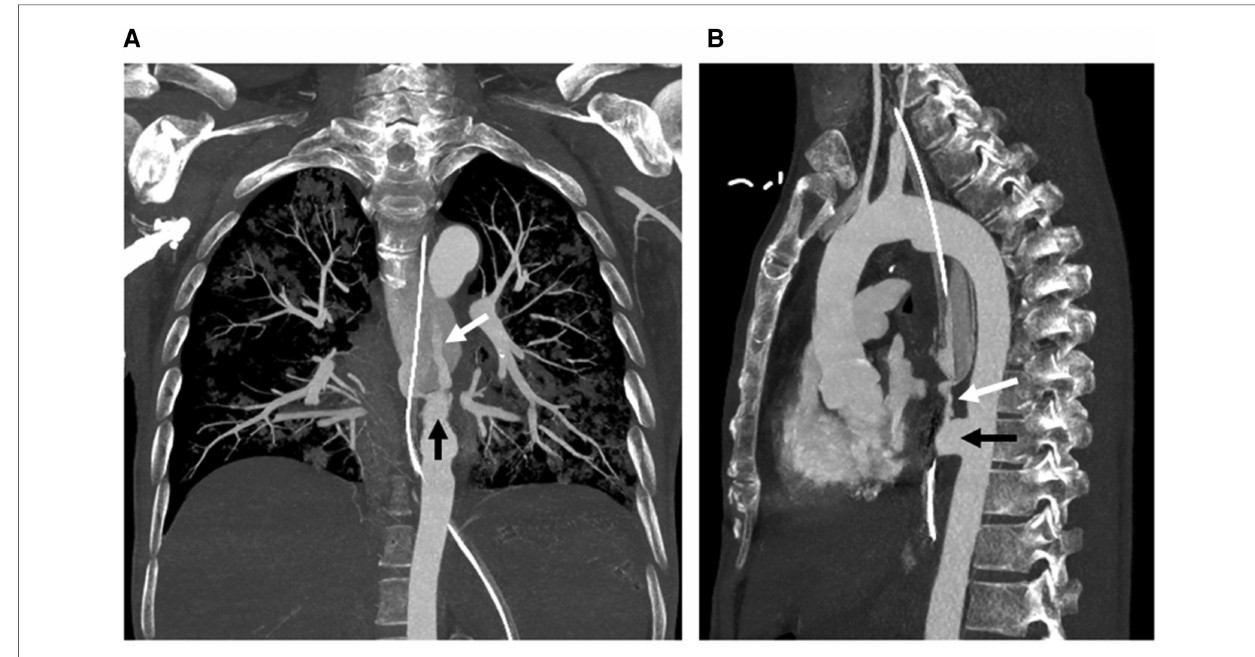
FIGURE 2 Coronal ( A ) and sagittal ( B ) maximum intensity projection images from computed tomography angiography show a descending aortic pseudoaneurysm (black arrow) at the level of the aortoesophageal fi stula, complicated with rupture and contrast material extravasation (white arrow) into the esophagus (with a nasogastric tube in situ